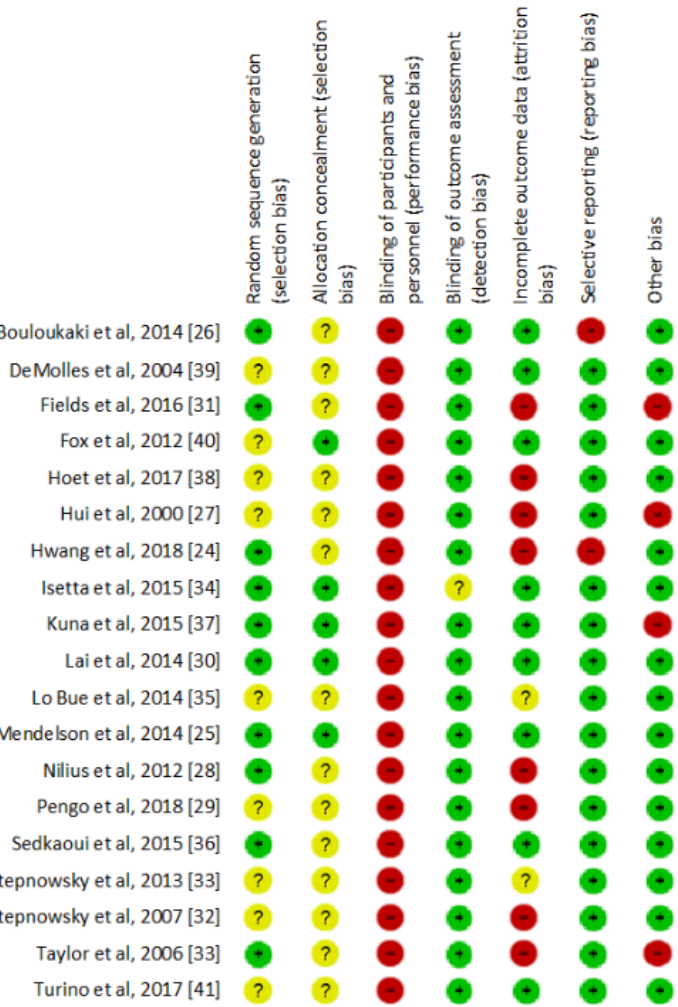
Figure 2. Risk of bias for each individual study included in this meta-analytic